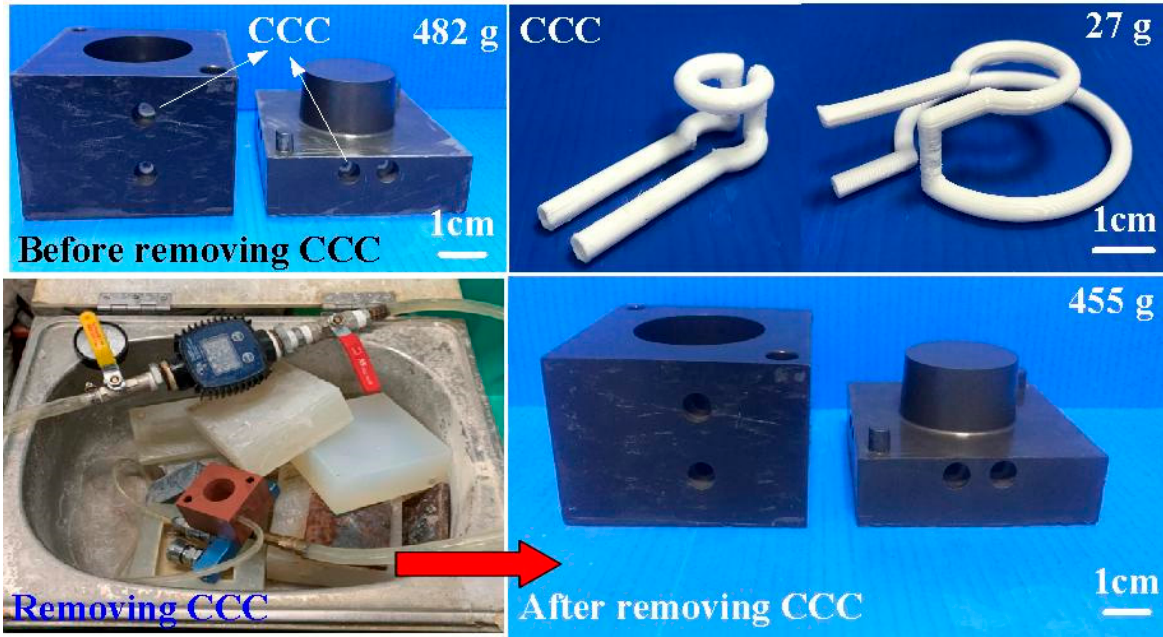
Figure 9. Results of before and after removing CCC.